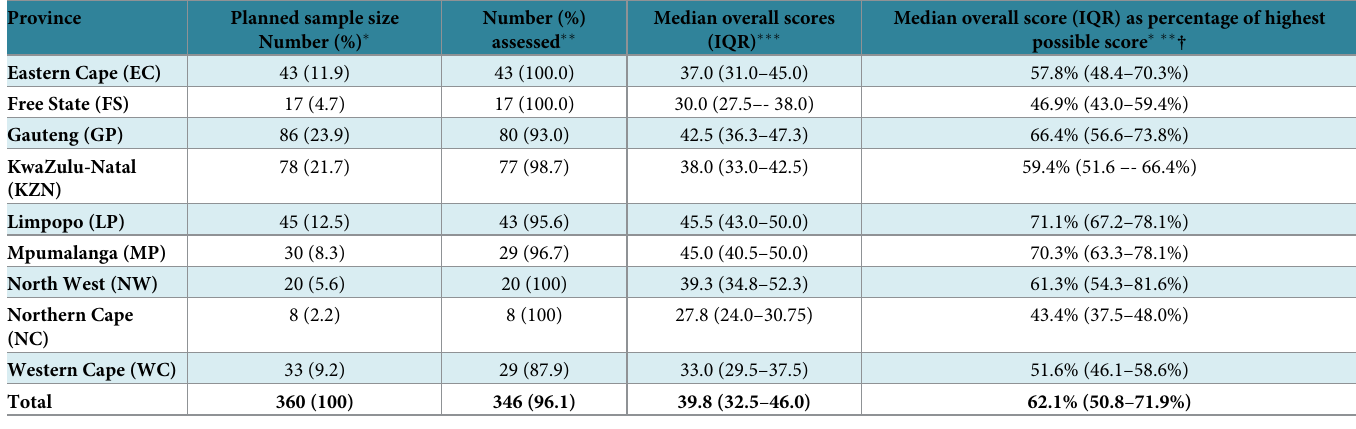
Table 2. Distribution of median overall score and percentage by province: Quality of HIV rapid testing practices, South Africa. Province